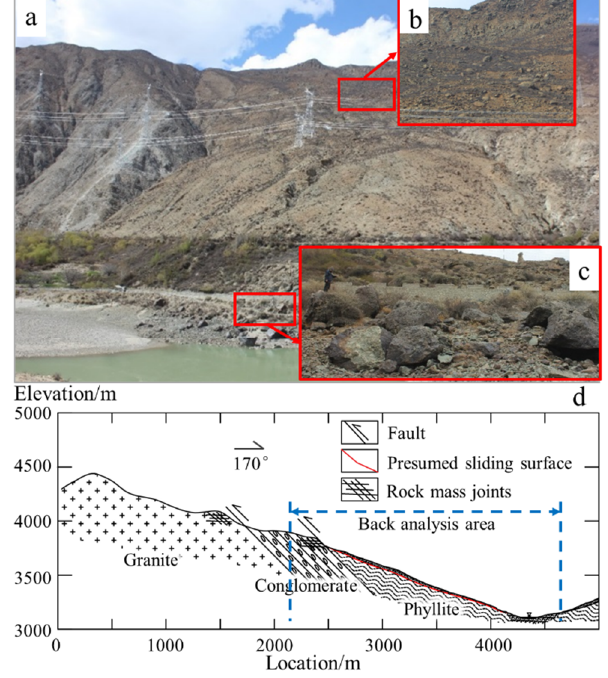
Figure 6. Picture of rockfall in Zhaxilin village ( a ). Full view of the rockfall ( b ). The deposition around the rear edge of the slope; ( c ). Deposited rocks along the river bank ( d ). A brief geological profile of the slope (profile 3-3′ in Figure 2).